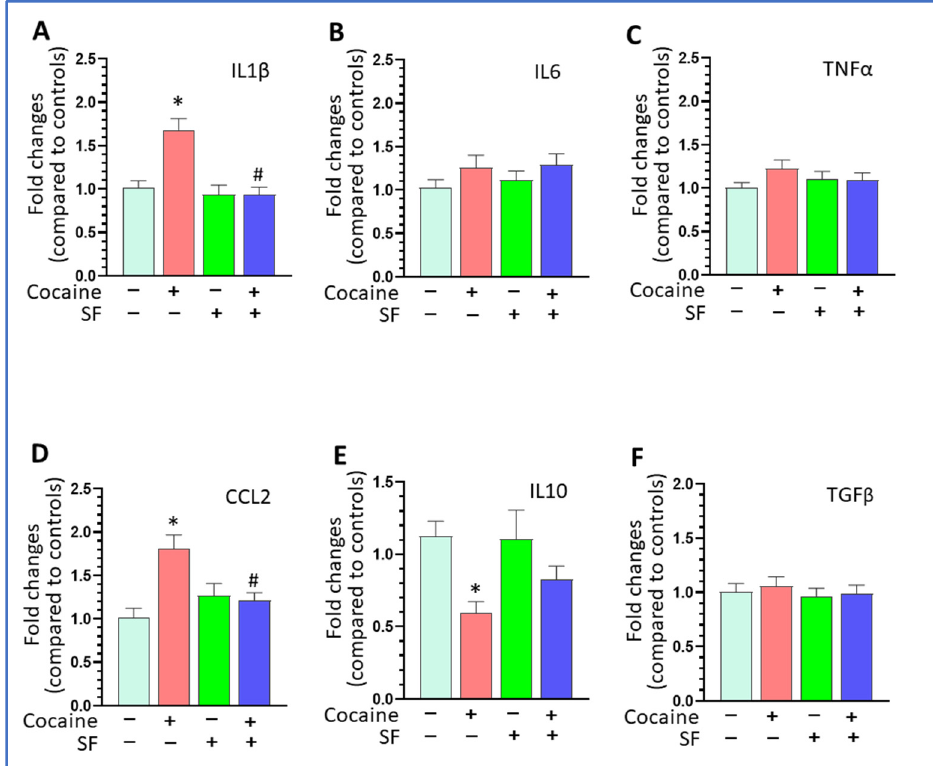
Figure 2. SF blunted cocaine-mediated neuroinflammation in the striatum. ( A ) Cocaine increased IL1 β levels and SF blocked the increase (* p < 0.05, vs. sham + saline; # p < 0.05, SF + cocaine vs. sham + cocaine, n = 5). ( B ) There was no difference on IL6 levels across the four groups of mice ( p = 0.3794). ( C ) There was no difference on TNF α levels groups of mice ( p = 0.3373). ( D ) Cocaine increased CCL2 levels and SF blocked such upregulation mediated by cocaine (* p < 0.05, vs. sham + saline; # p < 0.05, SF + cocaine vs. sham + cocaine, n = 5). ( E ) Cocaine decreased IL10 levels (* p < 0.05, vs. sham + saline). ( F ) There was no difference in TGF β levels across groups of mice ( p =